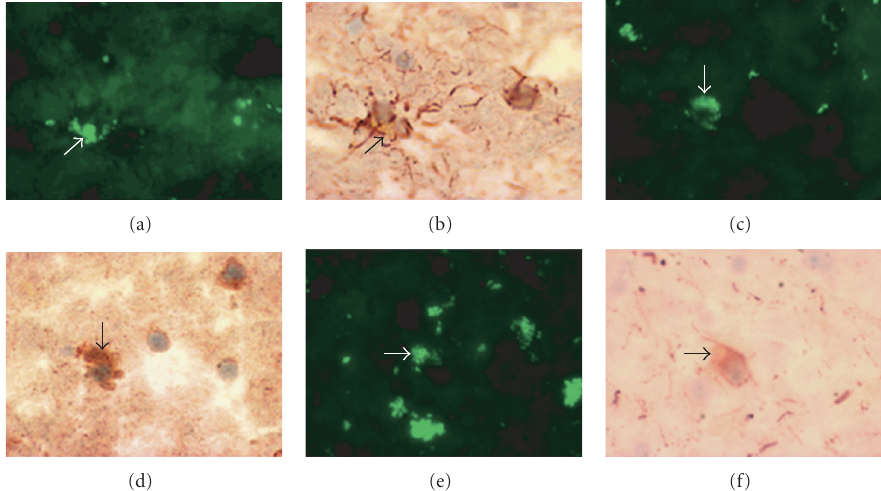
Figure 1: Representative images of double immunolabelling studies to demonstrate the infection of astrocytes, microglia, and neurons with Chlamydia pneumoniae in the AD brain. Chlamydia pneumoniae-infected cells were identified in all cases using the FITC- labelled monoclonal antibody targeting the Chlamydia LPS (Pathfinder TM; a, c, e). Astrocytes (b) and microglia (d) were identified by immunostaining using monoclonal antibodies targeting GFAP and iNOS, respectively. Neurons were identified by immunostaining with a monoclonal antibody targeting neuron-specific microtubule-associated protein (f). Images in all panels were obtained using a objective. In all panels, arrows indicate cells labelling with the Pathfinder TM and surface marker-specific monoclonal antibodies. (Reproduced from [54] with courtesy of Department of Immunology and Microbiology, Wayne State University School of Medicine, Detroit, MI, USA, and with permission of FEMS Med Lett ).